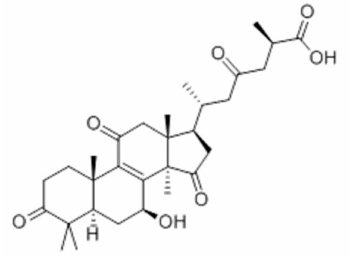
Figure 4. Ganoderic acid